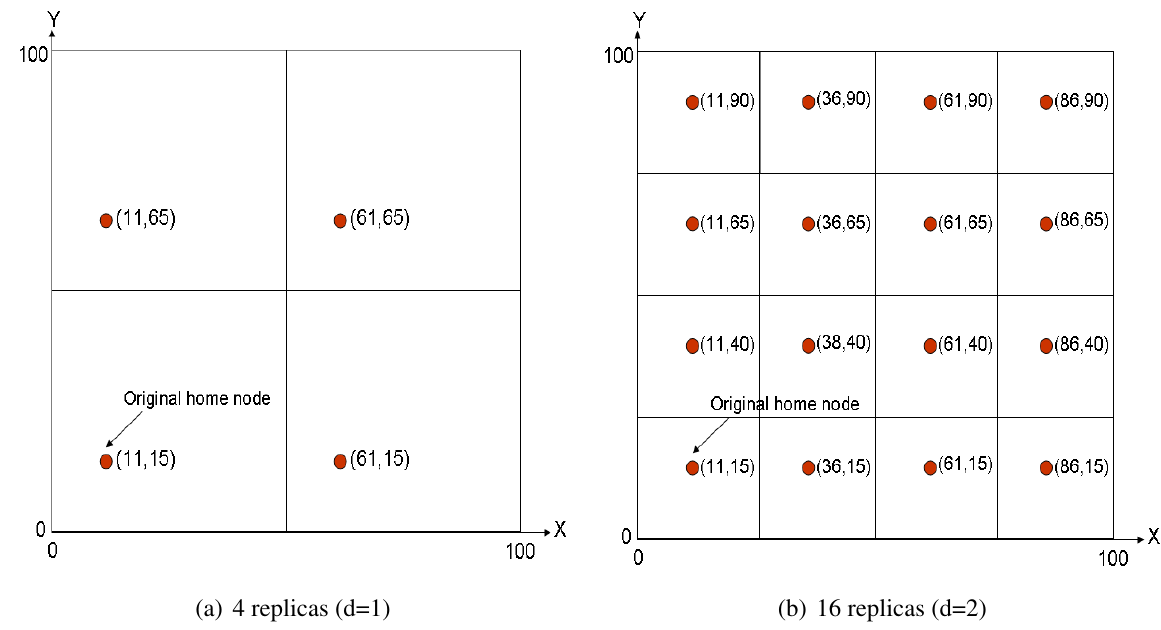
Figure 2. Multi-replication grid in GHT